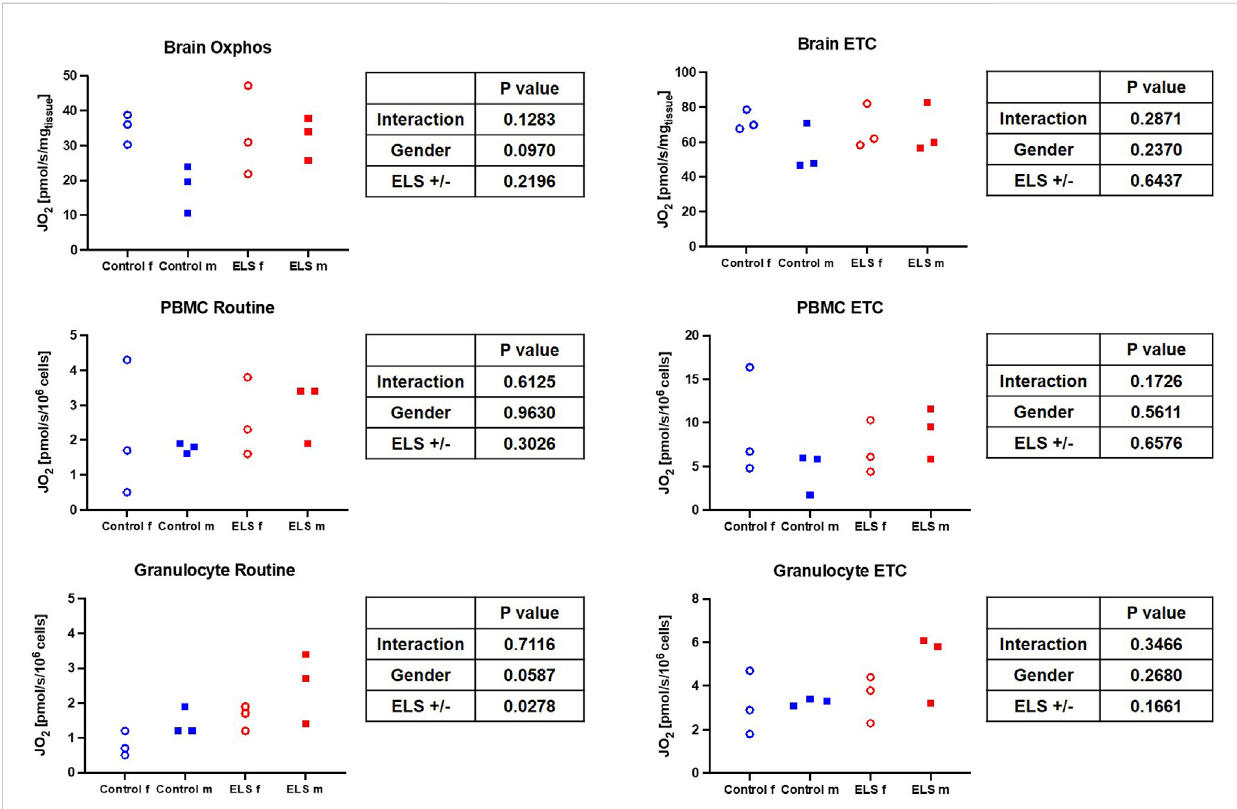
FIGURE 3 Mitochondrialrespiration(leftcolumn:oxidativephosphorylation(OxPhos)/physiologicalcouplingstate(Routine);rightcolumn:maximumelectron transport capacity of the respiratory chain in the uncoupled state) in immediate post mortem brain specimen (J O 2 [pmol/s/mgtissue]) (upper panel) as well as in isolated peripheral blood mononuclear cells (PBMC, middle panel) (J O 2 [pmol/s/10 6 cells]) and granulocytes (lower panel) J O 2 [pmol/s/10 6 cells(])forthecontrol(bluesymbols)andEarlyLifeStress(ELS;redsymbols)groupsinmale(solidsquares)andfemale(opencircles)swine.Notethat as expected, ETC., in PBMC was markedly higher than in granulocytes.